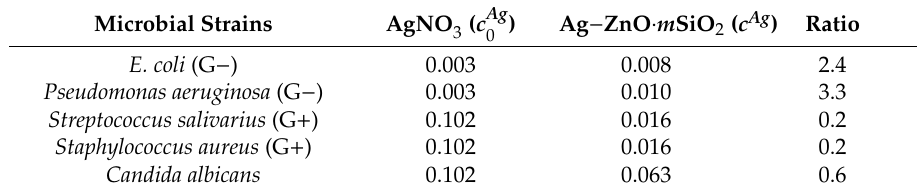
Table 3. Partial MIC of Ag (mg · cm − 3 ) with respect to the Ag content in the material and their corresponding concentration ratios. All values have been subsequently